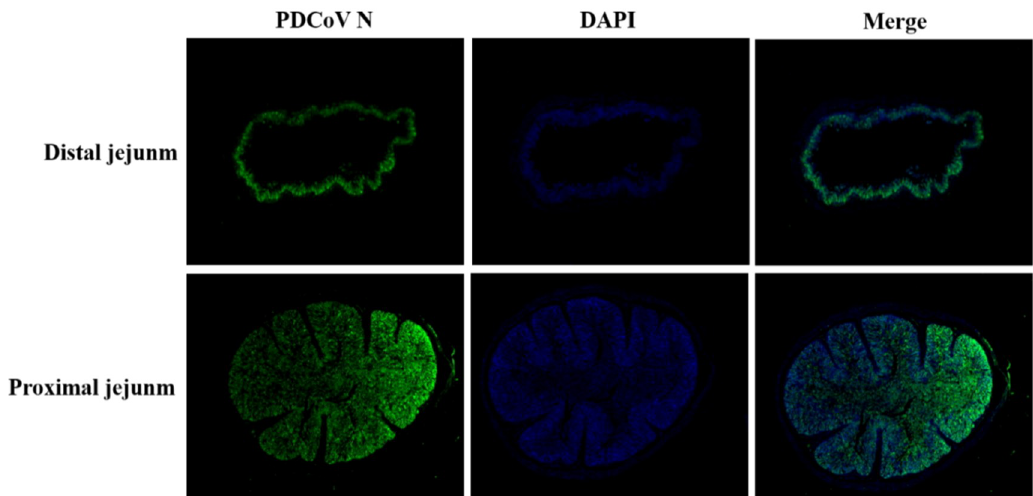
Figure 11. PDCoV N-protein was detected in sections of jejunum by immunofluorescence staining. Jejunum samples from five-old-day piglets infected with PDCoV CHN-SC2015 were fixed and then stained with the rabbit anti-PDCoV N protein monoclonal antibody and FITC-conjugated goat anti-rabbit IgG (green); the nucleus was counterstained with DAPI (blue). Magnification = 2×.